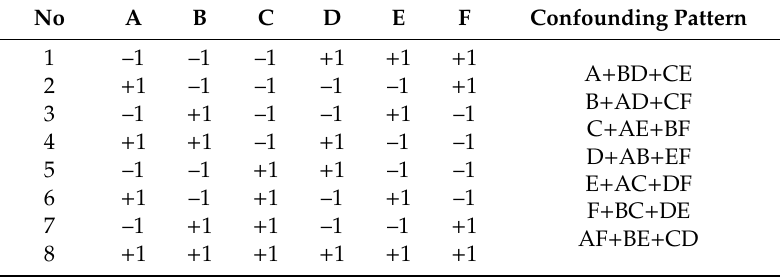
Table 3. Array of